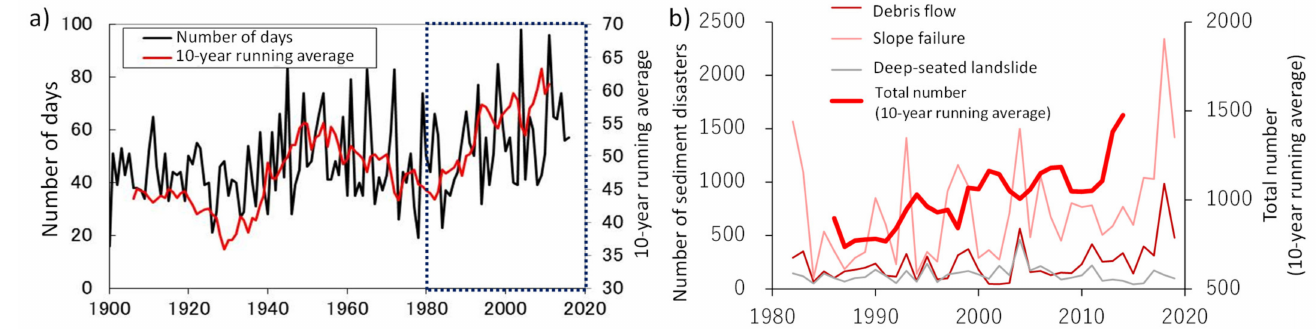
Figure 1. The relationship between the number of sediment disasters increasing from 1980 to 2019 with an increase in the number of days with precipitation of 100 mm or more: ( a ) The numbers of days with precipitation of 100 mm or more and 10-year running average in 51 observation stations in Japan (based on Uchida et. al., 2017 [32]), ( b ) the number of sediment disasters and 10-year running average, reported by the MLIT, from 1980 to 2019 in Japan.